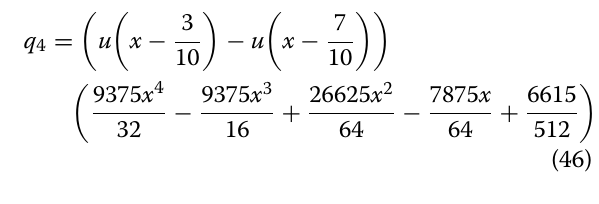
Table 8 Lift-off points x 1 and x 2 at q = q 3 for various N The